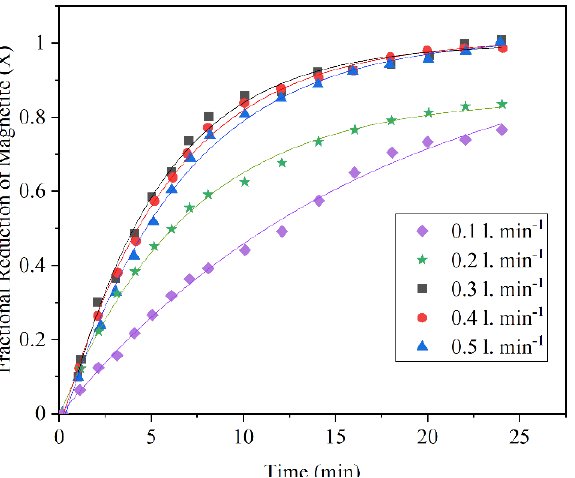
Figure 8. Fractional reduction of magnetite vs. time plot for the reduction of magnetite ore fines at different flow rates at 900 °C [38] “modified”.